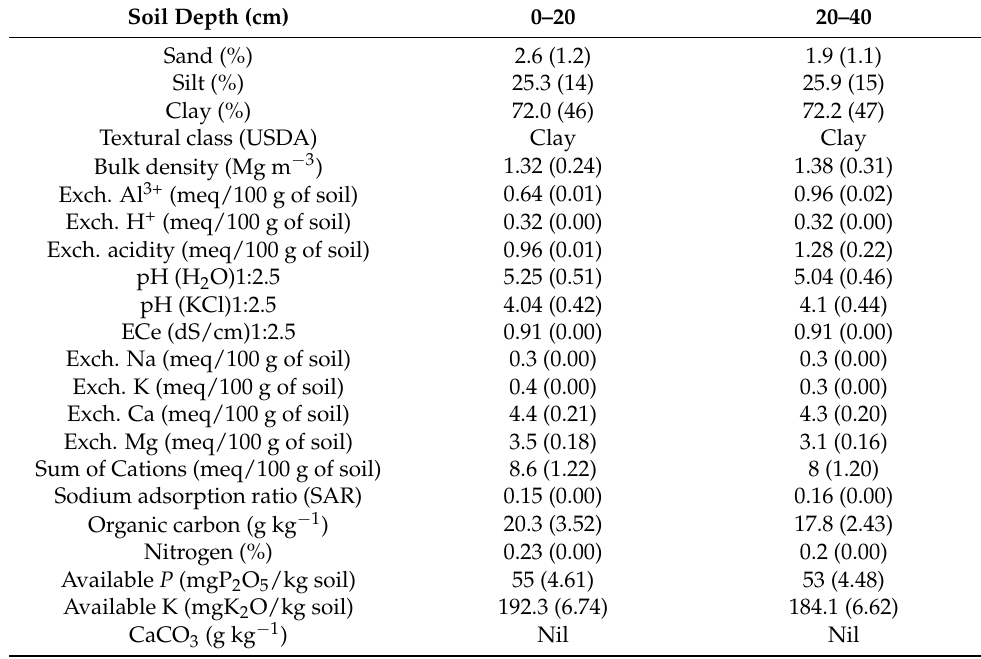
Table 2. Some physical and chemical properties of representative soils. Standard deviations are presented in parenthesis ( ±